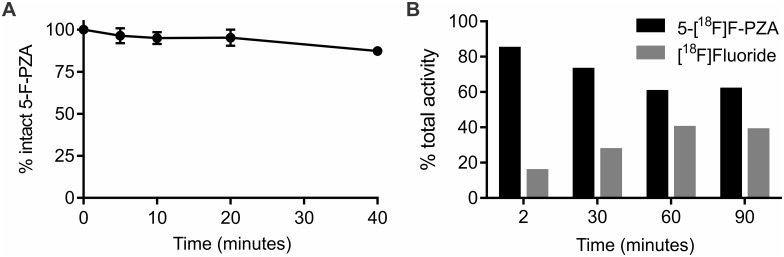
5-[18F]F-PZA stability and defluorination.(A) Percentage of intact 5-F-PZA after incubation with mouse liver microsomes over 40 min. The amount of intact 5-F-PZA available at each time point was determined by LC-MS and is presented as percentage of total 5-F-PZA added. (B) Percentage of intact 5-[18F]F-PZA and [18F]fluoride after incubation of 5-[18F]F-PZA with mouse liver homogenates over 90 min. The amount of 5-[18F]F-PZA and [18F]fluoride was determined by using radioactive TLC. Data are presented as the percentage of total activity on the TLC plates.